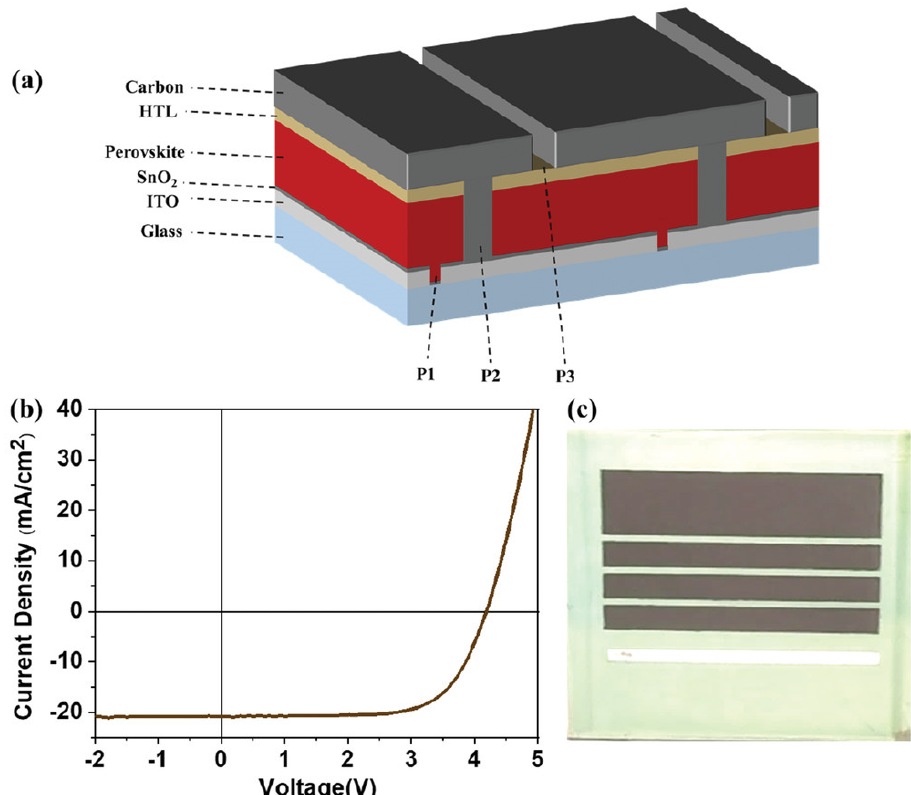
Figure 33. ( a ) Schematic diagram of the carbon electrode perovskite solar module. ( b ) J–V curves of the carbon PSM on the 25 cm 2 substrate. ( c ) The digital image of planar carbon PSM [64]. (Reproduced from Ref. [64], 10.1002/aenm.202101219, with permission.) Table 3. Summary of the highest PCEs obtained so far in PSCs employing a C electrode with active area 1–3.5 cm 2